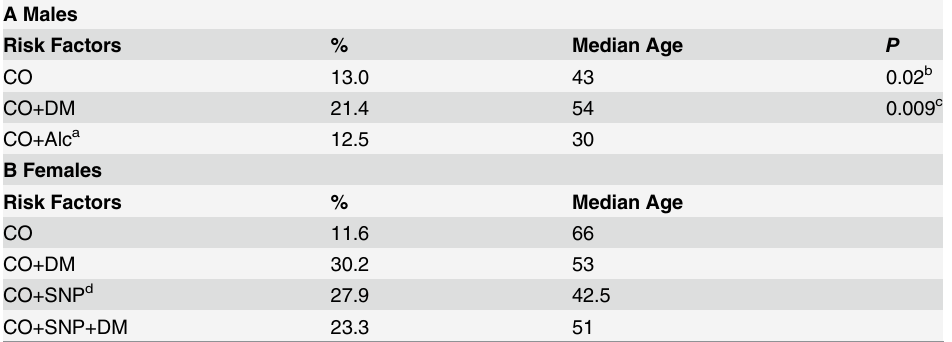
Table 4. Percentage and median age of participants with cirrhosis/advanced fibrosis, with central obesity (CO) alone or in combination with diabetes (DM), excess alcohol consumption (Alc) or 2 risk alleles of PNPLA3 rs738409 (SNP) in males and in